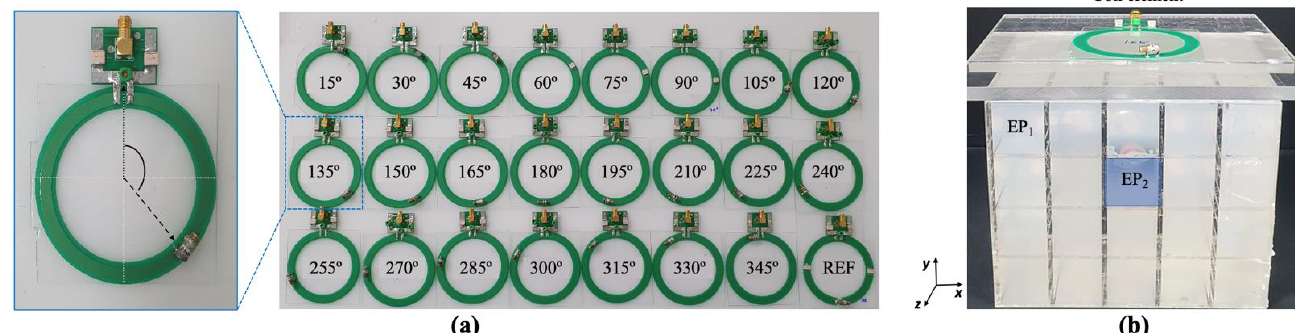
Figure 3. RF coils created for this study, showing ( a ) single coil with capacitor placed at 210° with corresponding matching circuit, and 24 coils, including reference coil, for coil combinations with capacitor positioned between 15° and 345°, in 15° intervals. ( b ) ROI phantom with 20 ROIs, and location of coil on top for MRI imaging.